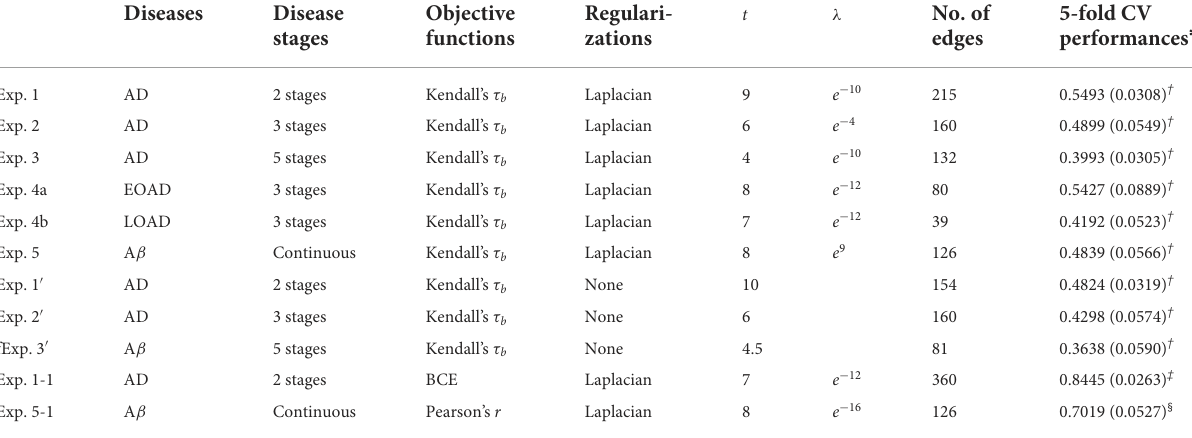
TABLE 3 Selected hyperparameter values and the corresponding results for each